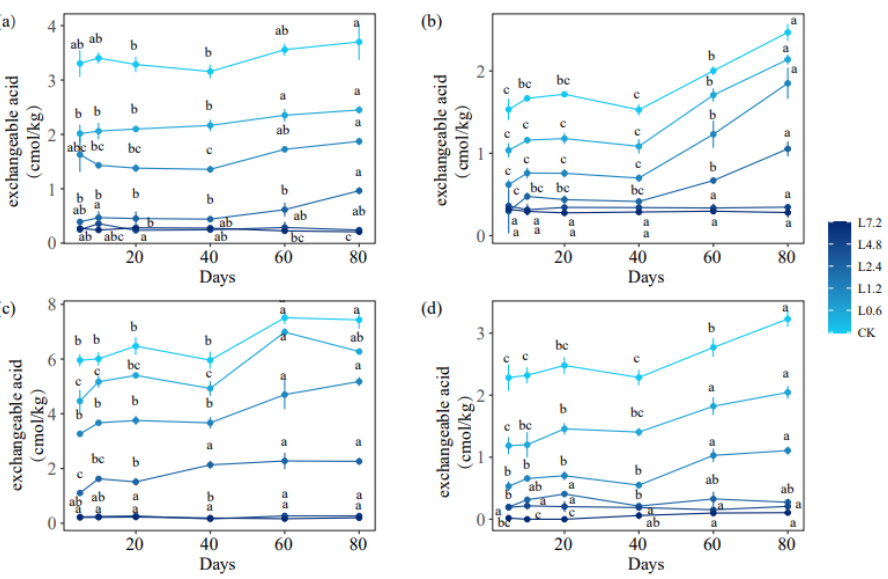
Figure 2. Dynamics of the exchange acid content of soils ( a – d ). Different lowercase letters represent significant differences between different incubation times for the same treatment ( p < 0.05).